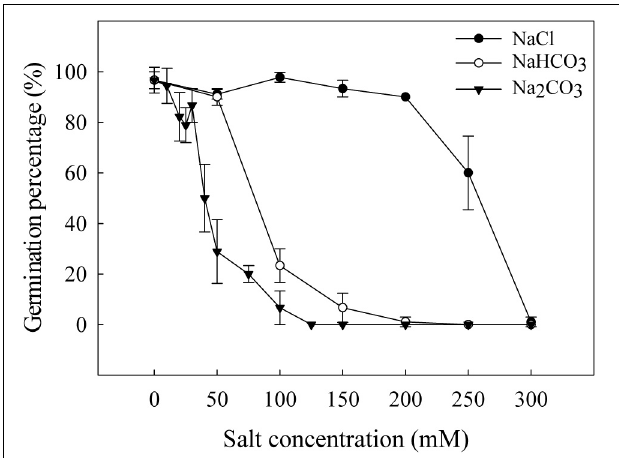
FIGURE 1 | Germination percentage of canola seeds under varying levels of saline-alkali stress.